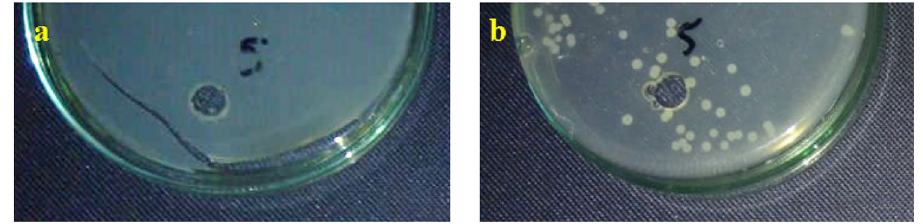
Figure 12. Antimicrobial effect of Ag/ZnO@BC against Klebsiella pneumonia ( a ) and Escherichia coli ( b ) .